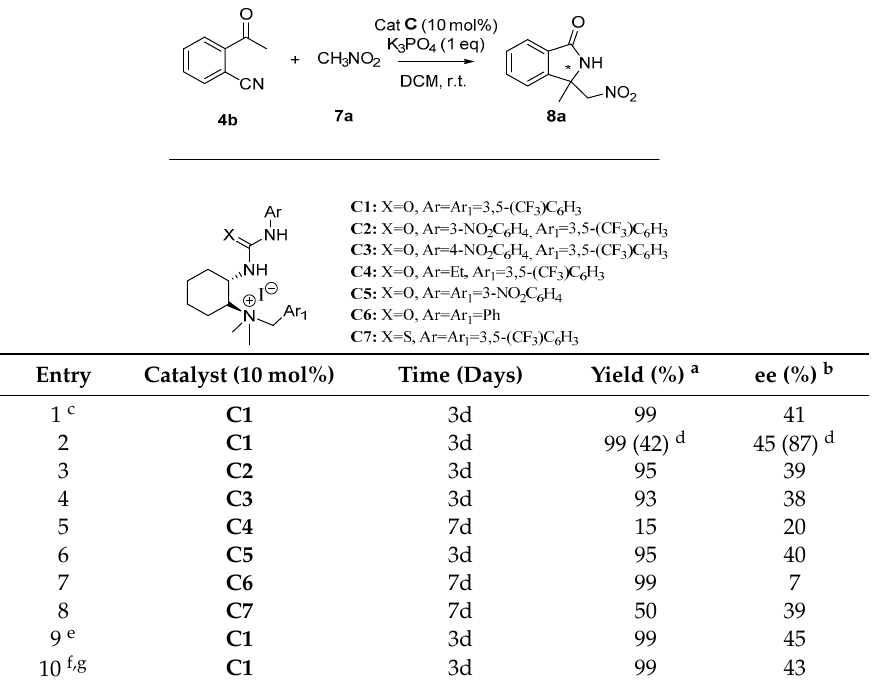
Table 3. Screening of different trans -1,2-cyclohexyldiamine based PTC.